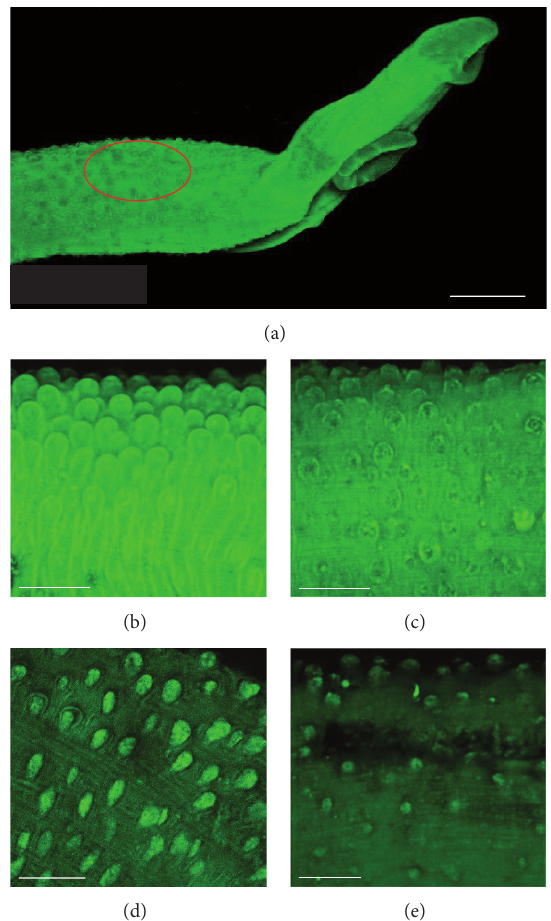
Figure 4: Confocal laser scanning microscopy investigation of the crude hydroalcoholic extract of T. vulgare (TV) in vitro schistosomicidal effect. In these experiments, pairs of adult worms were incubated in 24-well culture plates containing RPMI 1640 medium and treated with different concentrations of TV. After 120 h of incubation or in the case of death, adult male worms were fixed in FAA solution and fluorescent images were obtained using confocal microscopy (Carl Zeiss LSM 510 META). General view of the anterior worm region showing, in red, the location where tegument was analysed (a). Control worms in RPMI 1640 with 0.5% DMSO (b), and 10 𝜇 M praziquantel (c), compared to worms treated with 50 𝜇 g/mL of TV (d), and 100 𝜇 g/mL of TV (e). Scale bars, 500 𝜇 m (a) and 50 𝜇 m